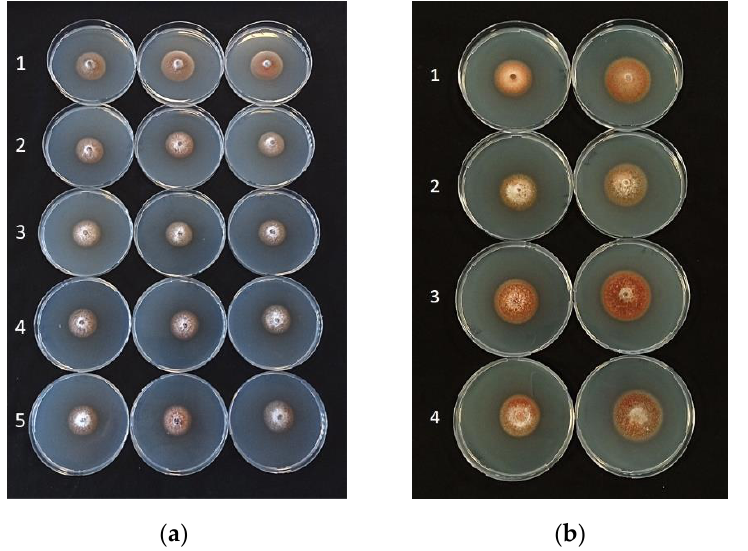
Figure 3. ( a ) Activity of bacterial VOCs against Plenodomus tracheiphilus isolate PT5: 1, control plates; 2, Bacillus amyloliquefaciens QST713 (former B. subtilis ; Serenade ® Aso); 3, B. amyloliquefaciens D747 (Amylo-X ® ); 4, B. amyloliquefaciens FZB24 (Taegro ® ); 5, B. amyloliquefaciens MBI600 (Serifel ® ). ( b ) Effects induced on four different isolates (1–4) of P . tracheiphilus by VOCs produced by B. amylolique- faciens QST713 (former B. subtilis ; Serenade ® Aso) (left) compared with control (right).